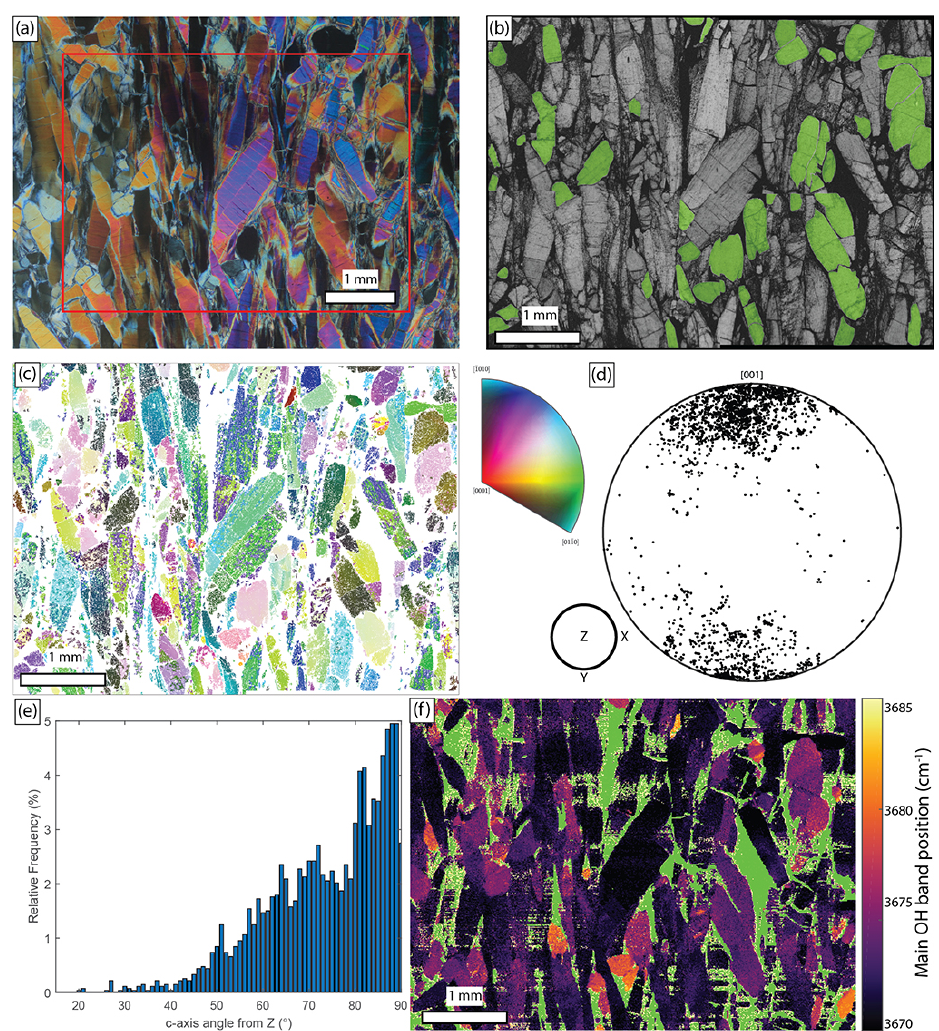
Figure 5. EBSD and Raman map 3 on thin section MF01b. (a) Cross-polarised light photomicrograph with mapped area in the red box. (b) Image quality band contrast map with selected grain from the EBSD analysis highlighted in green. (c) Inverse pole figure (IPFZ) map coloured with the inverse pole figure scheme shown on the right. (d) Pole figures (lower-hemisphere equal area, one point per grain) of [001] orientations ( c -axis). (e) Histogram of the relative frequency of the c -axis angle from z for each grain. (f) Raman-based map displaying the position of the main OH-stretching band of lizardite. Green areas represent chrysotile-dominated